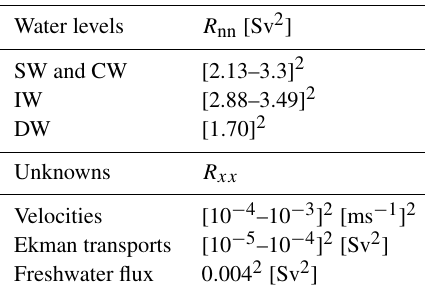
Table 1. A priori noise of equations corresponding to the surface water (SW), central water (CW), intermediate water (IW) and deep water (DW) levels and uncertainties of all unknowns of the inverse